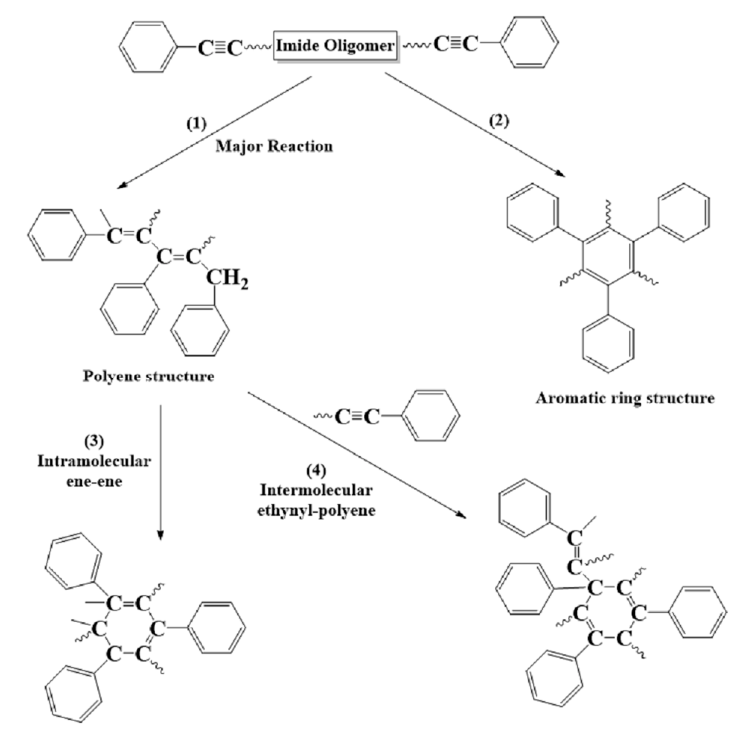
Figure 3. Proposed phenylethynyl curing